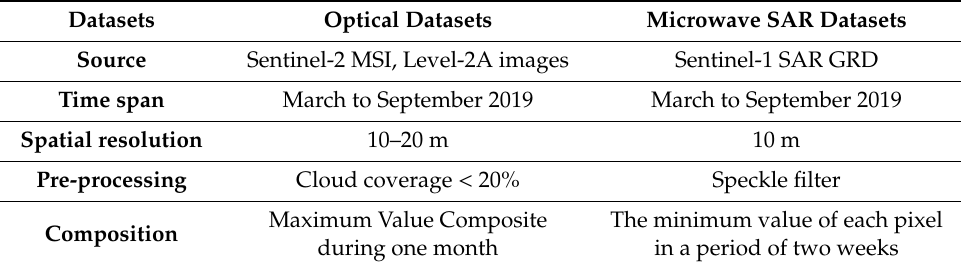
Table 1. The characteristics of the GEE derived SAR and optical data used for the study.